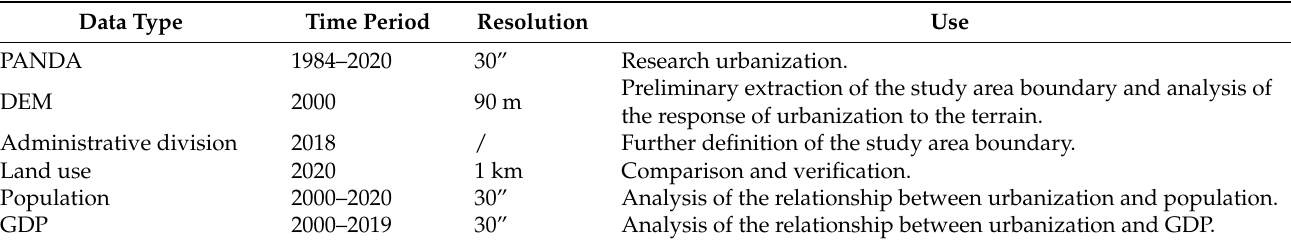
Table 1. The characteristics and use of the data.